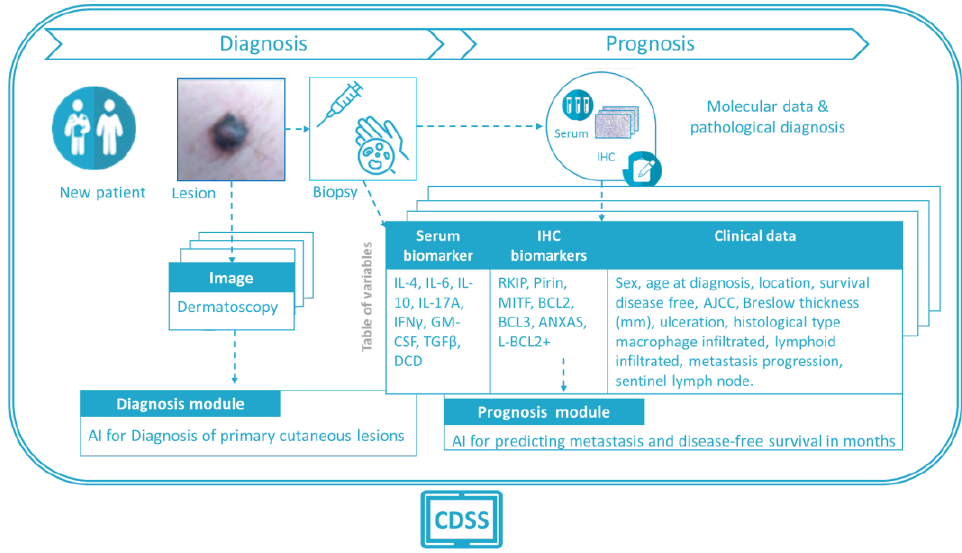
Figure 2. Scheme of the proposed workflow used to incorporate the demographic and clinical data, the lesion images, and new molecular biomarkers into the AI models for melanoma diagnosis and prognosis.